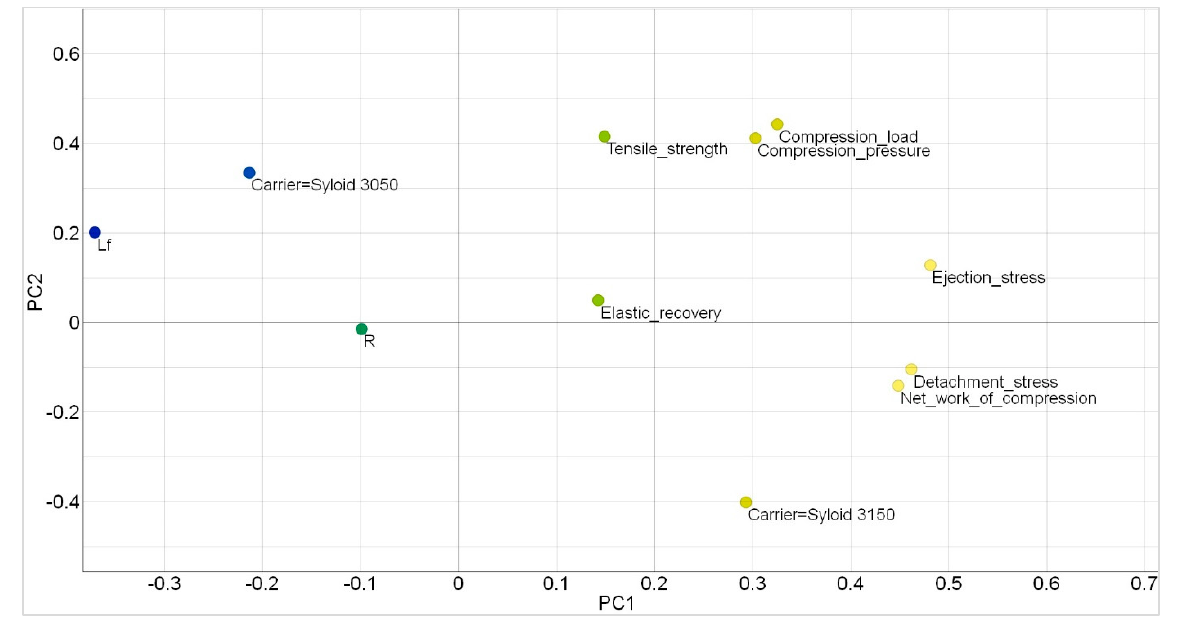
Figure 8. Results of principal component analysis for two Syloid ® carriers.